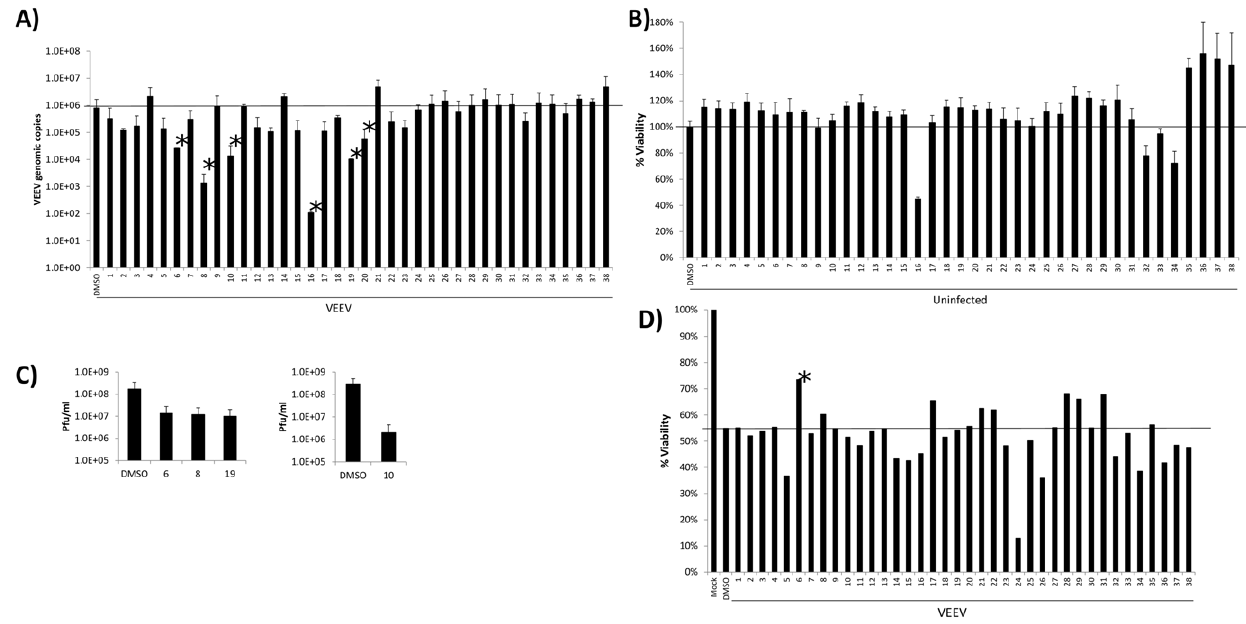
Figure 2. Identification of a BIO derivative that inhibits VEEV replication and CPE. A ) U87MG astrocytes were pretreated for 2 hours with DMSO or various BIO derivatives at 1 m M, infected with VEEV TC-83 at MOI 0.1, and post-treated with compounds. Twenty-four hours post infection viral supernatants were collected and assayed for viral replication by q-RT-PCR. Compounds with an asterisk displayed greater than 1 log inhibition of viral replication. The horizontal bar indicates the level of viral replication displayed by the DMSO control. B ) U87MG astrocytes were treated with DMSO or various BIO derivatives at 1 m M. Forty-eight hours post infection cell viability was measured by CellTiter Glo luminescence cell viability assay. The horizontal bar indicates the cell viability displayed by the DMSO control (set to 100%). C ) U87MG astrocytes were pretreated for 2 hours with DMSO, BIO, # 6, # 8, # 10, or # 19 at 1 m M, infected with VEEV TC-83 at MOI 0.1, and post-treated with compounds. Twenty-four hours post infection viral supernatants were collected and assayed for viral replication by plaque assays. D ) BIO derivatives were assayed for their ability to inhibit VEEV induced CPE. U87MG astrocytes were pretreated for 2 hours with DMSO or various BIO derivatives at 1 m M, infected with VEEV TC-83 at MOI 0.1, and post-treated with compounds. Forty-eight hours post infection CPE was measured by MTT assay. Mock infected cells are displayed at 100% viability. The horizontal bar indicates the cell viability displayed by the VEEV infected and DMSO control. Compound # 6 has an asterisk as cells treated with it displayed the greatest cell viability following VEEV